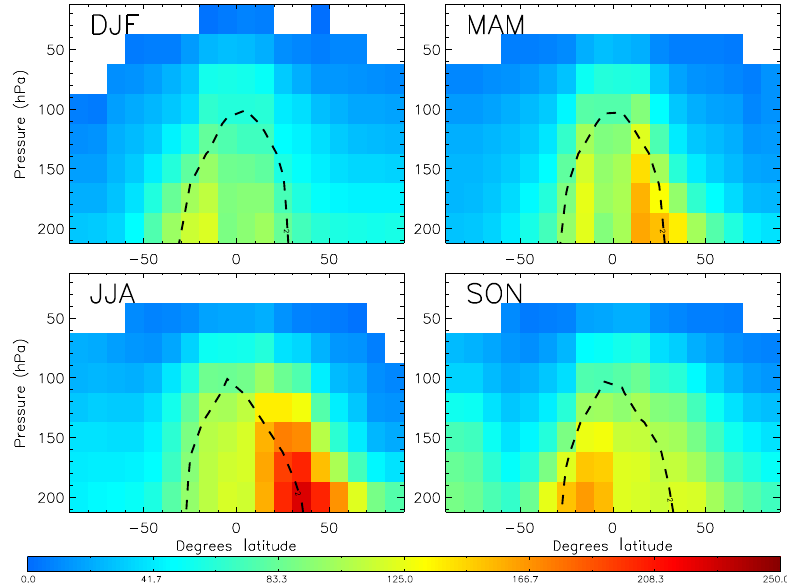
Figure 5. Zonal mean MIPAS PAN (pptv) from the IMK retrieval for 2007–2008 in DJF, MAM, JJA, and SON. The black dashed lines show the dynamical tropopause (defined as ± 2PVU) based on ERA-Interim data.